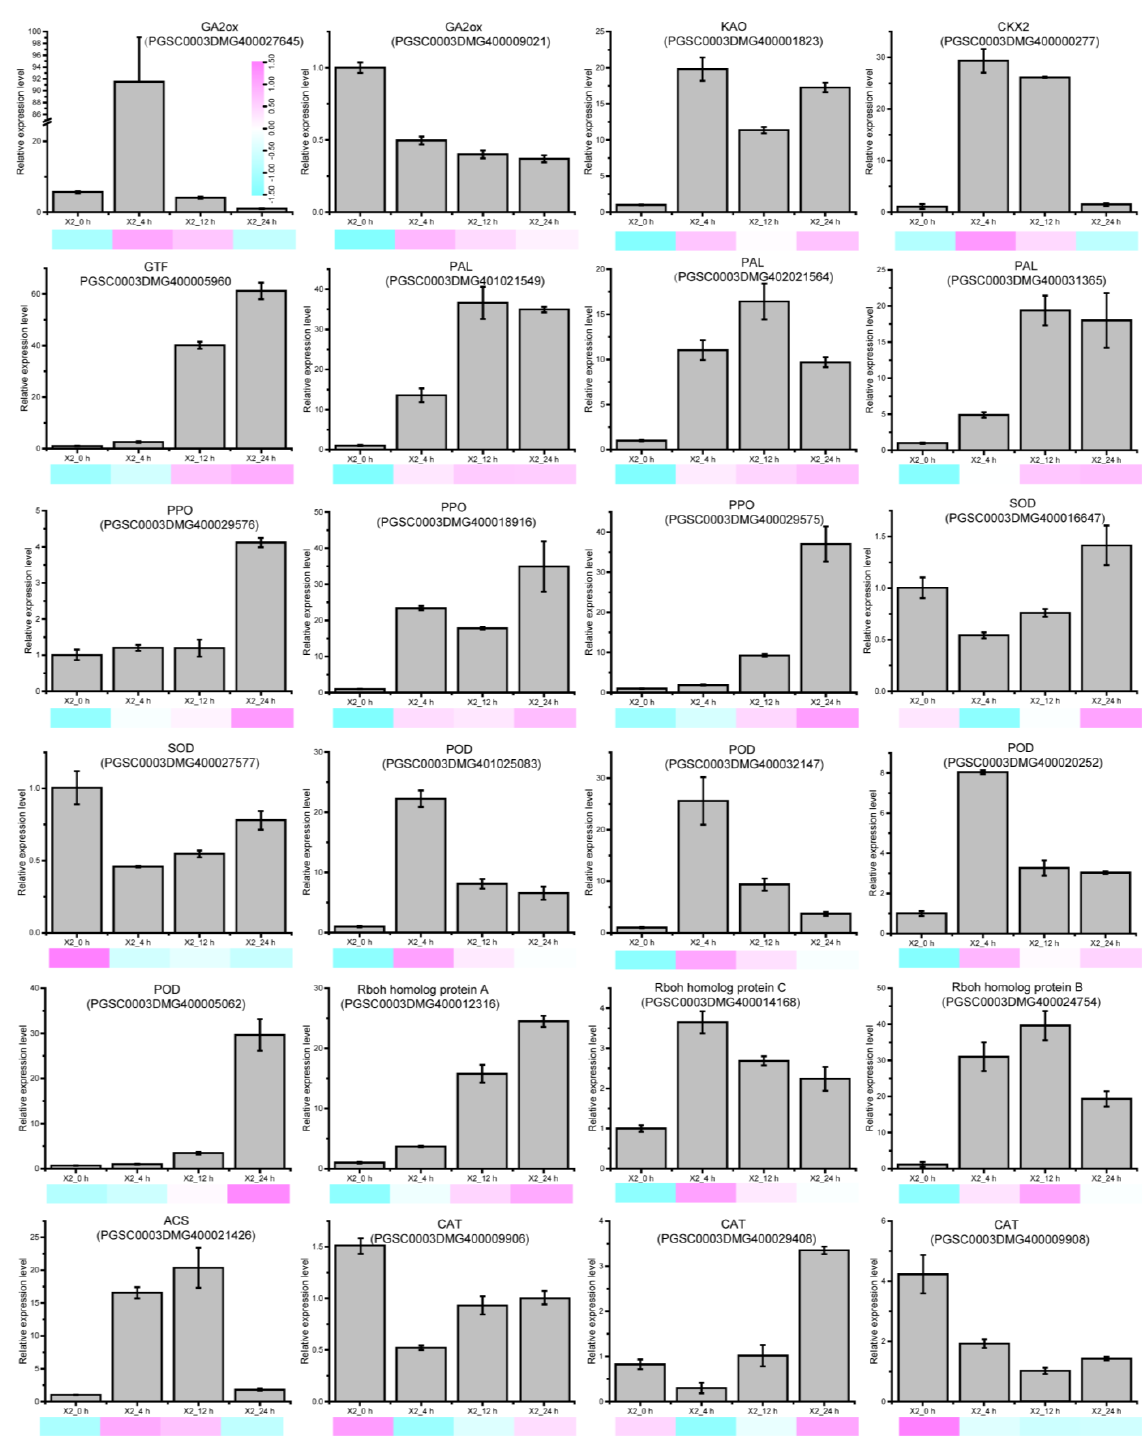
Figure 6. Expression profiles of signaling molecule biosynthesis, enzymatic browning related DEGs in potato tubers after cutting. Cyan to purple indicates the FPKM values based on RNA-seq. Data are mean values ± SD (n = 3). GA2ox, gibberellin 2-oxidase; KAO, Ent-kaurenoic acid oxidase; CKX2, cytokinin oxidase/dehydrogenase 2; GTF, glucosyltransferase; PAL, phenylalanine ammonia-lyase; PPO, polyphenol oxidase; POD, peroxidase; CAT, Catalase; SOD, Superoxide dismutase; Rboh, Respiratory burst oxidase homolog protein; ACS, 1-aminocyclopropane-1-carboxylate synthase